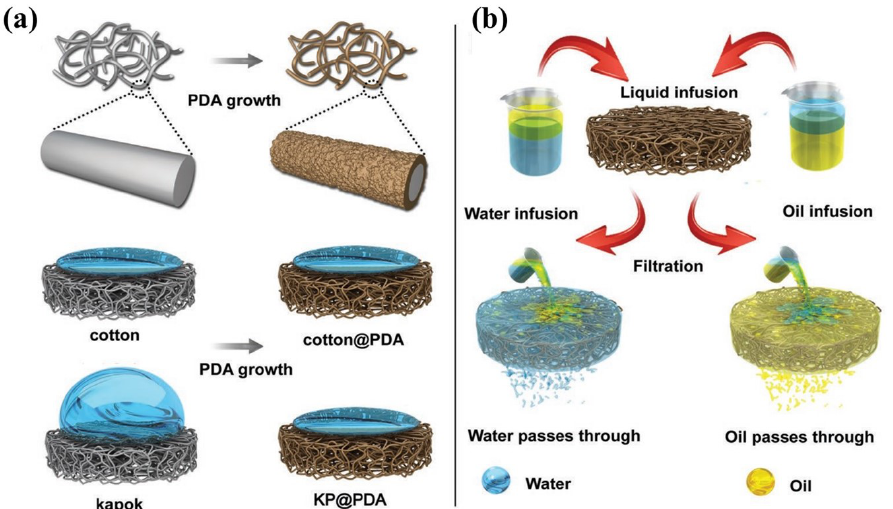
Figure 14. Schemes illustrate ( a ) the fabrication of PDA modified cotton fabric and kapok fabric and ( b ) the application of modified fabrics to selectively separate oil and water. Reproduced with permission [173]. Copyright 2020,